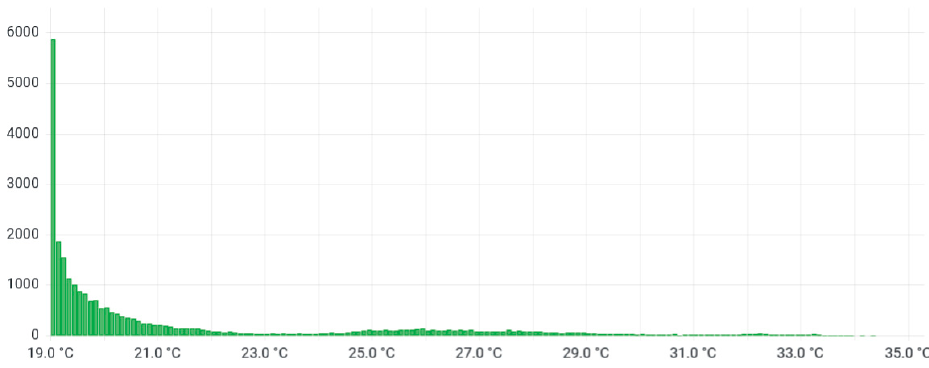
Figure 3. Indoor temperature histogram for a 2001–2010 building with linear penalty.